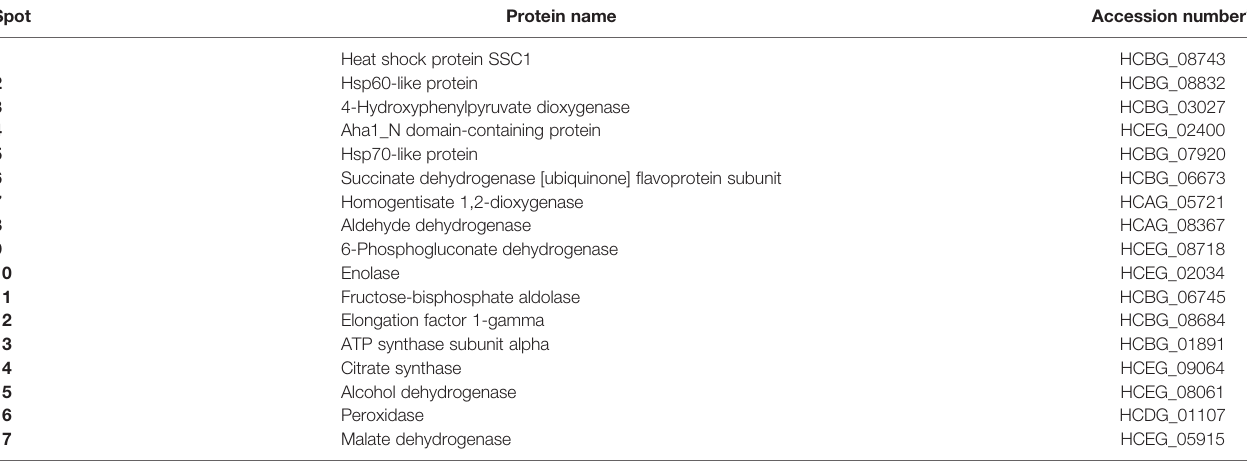
TABLE 1 | H. capsulatum antigenic proteins resolved by 2-D SDS-PAGE immunoblotting and identi fi ed by nanoLC-MS/MS